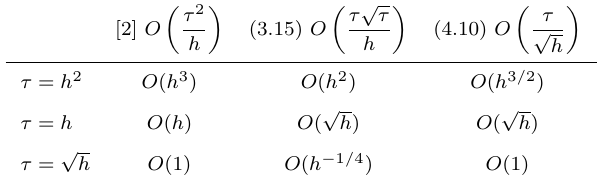
Table 3. Results of computational experiments: analysis of approximation error ψ n